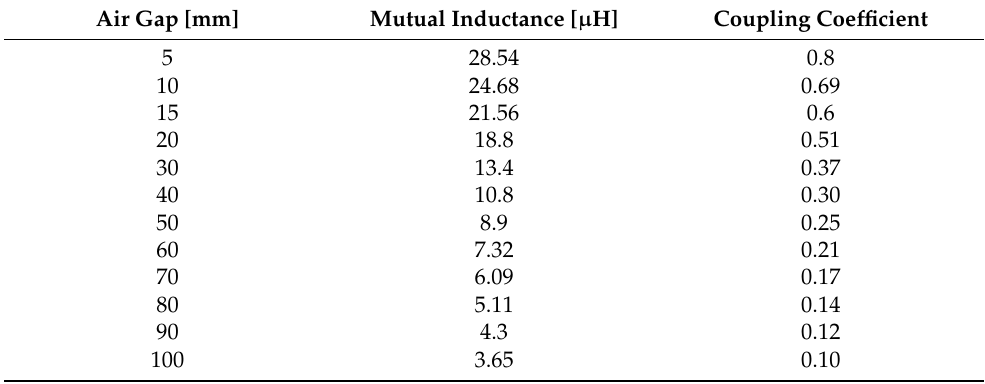
Table A2. Simulation results of coil mutual inductance and coupling coefficient according to air gap.